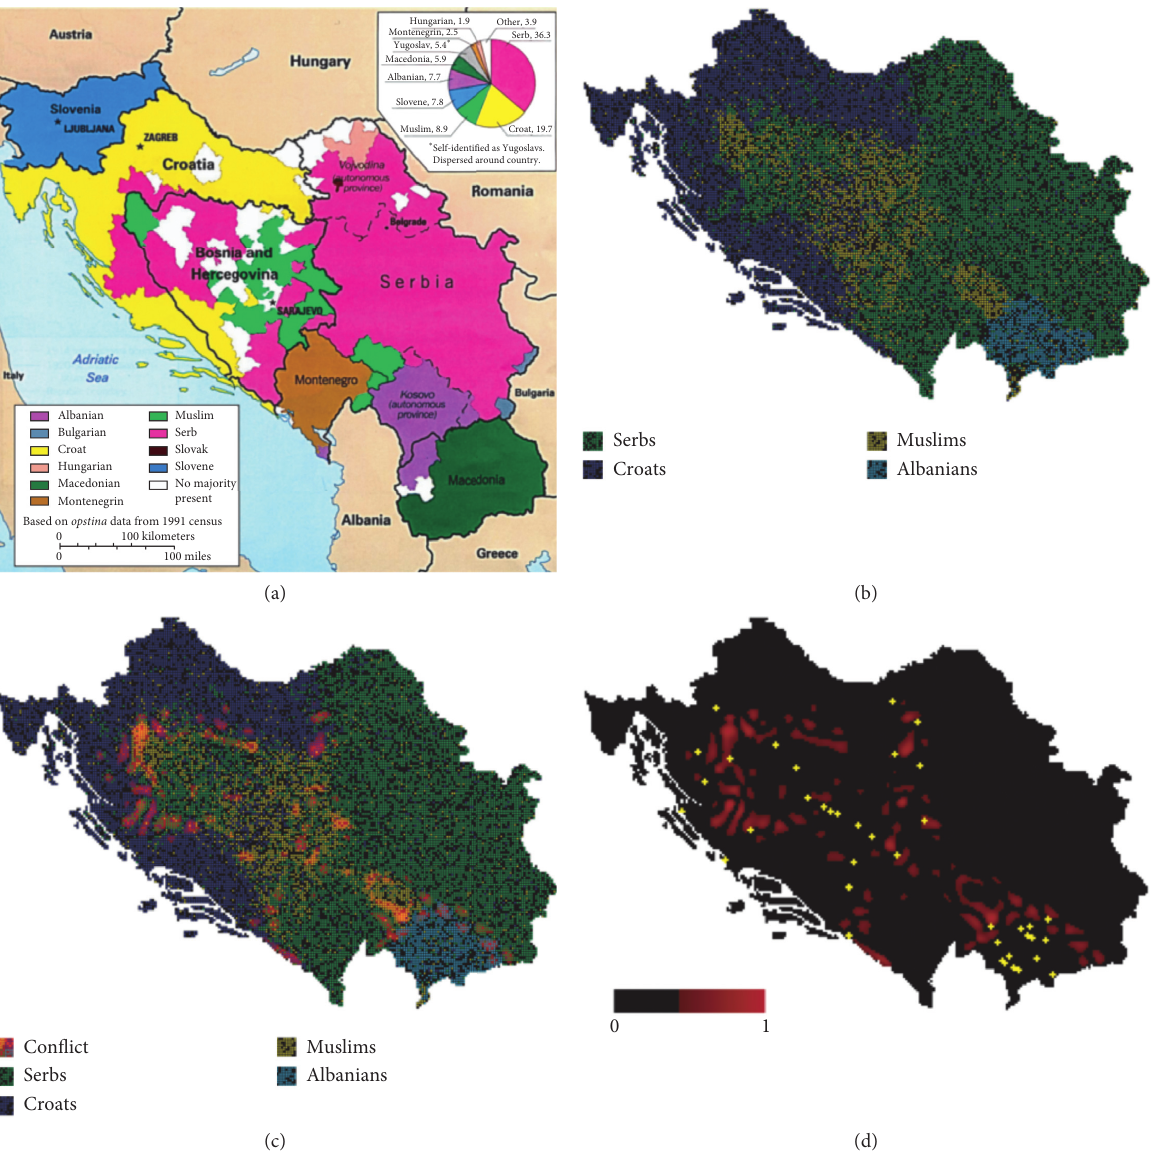
Figure 8: A figure from Lim et al.’s paper on ethnic violence [66]. The sites where their model predicts a potential for ethnic violence are shown in red in (c) and (d) with confirmed reports of ethnic violence depicted by the yellow dots in